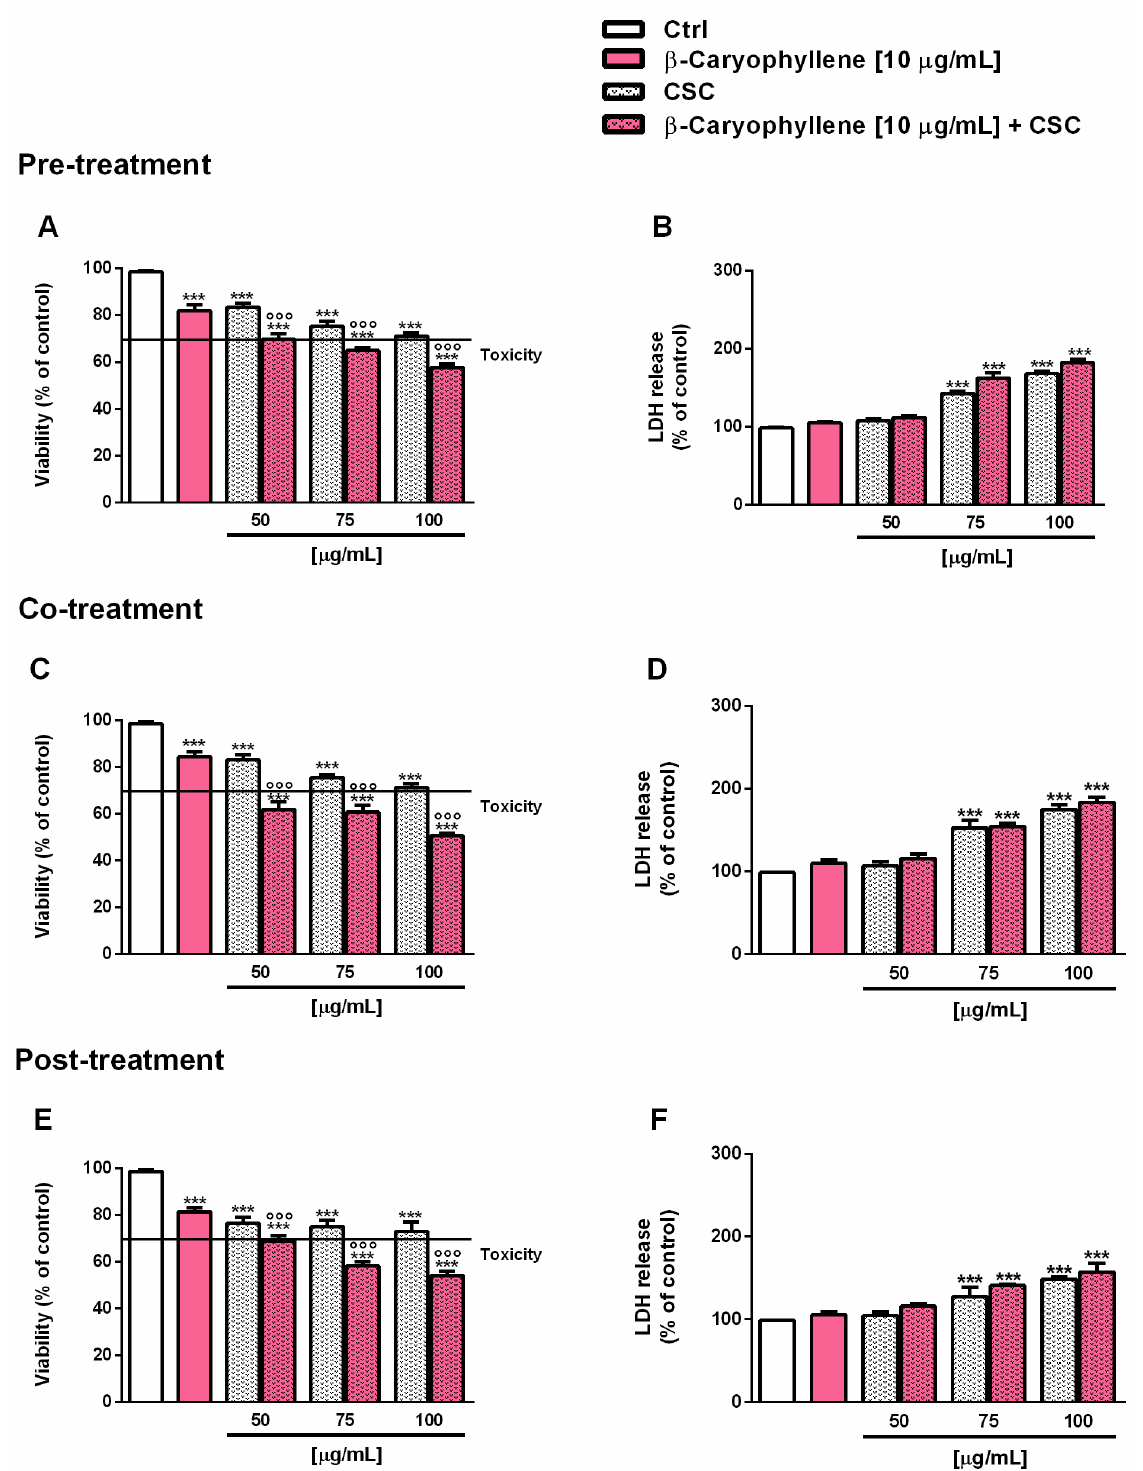
Figure 5. Cytotoxic effects of β -caryophyllene and cigarette smoke condensate (CSC) in triple-negative breast cancer MDA-MB-468 cells under pre-, co- and post-treatment protocols, measured as cell viability (A, C, E) and LDH release (B, D, F). Data are displayed as mean ± SE of at least three independent experiments with at least three technical replicates ( n = 9). *** p < 0.001, significant lowering of cell viability with respect to the control (ANOVA + Dunnett’s multiple comparison post - hoc test). °°° p < 0.001, significant difference the respect to CSC (Student’s t -test).